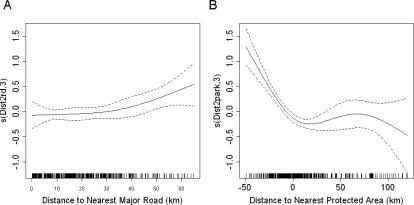
Estimated Conditional Dependence of Elephant Dung-Pile Numbers on Distance from Road (in Kilometres) and Distance to the Nearest Protected Area Boundary (in Kilometres)(A) shows the effect of distance from the road, and (B) shows the effect of distance to the nearest boundary of the protected area. Negative distances indicate locations inside protected areas. Estimates (solid lines) and confidence intervals (dashed lines), with a rug plot indicating observation density along the bottom of the plot, are shown. To avoid over-fitting, the degrees of freedom for this model were restricted to 3 for both covariates.